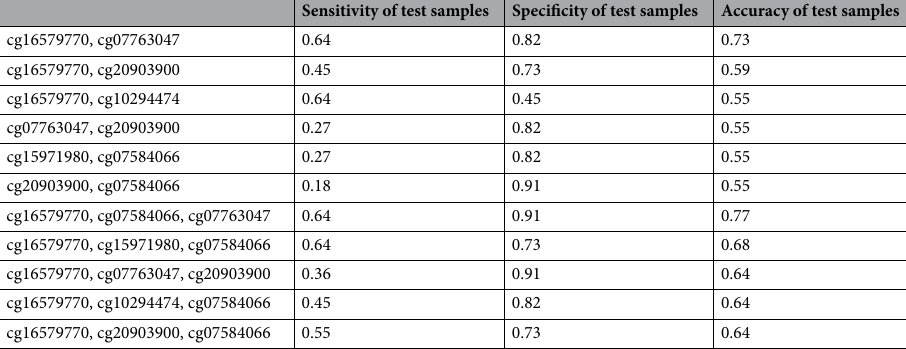
Table 5. Sensitivity, specificity, and accuracy using combinations of two or three DNA methylation sites for discrimination between AOD and HC. AOD, adult-onset depression; HC, healthy